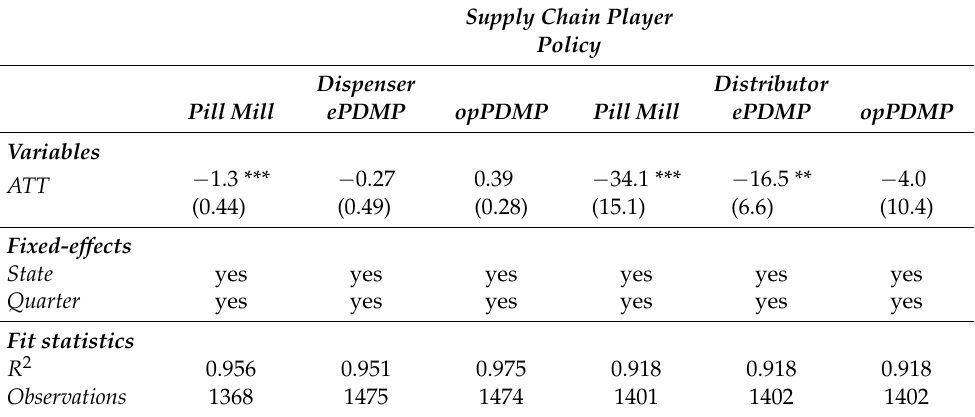
Figure 5. Amount of opioid drugs shipped from distributors in TN to neighbor states per destination capita after OP-PDMP implementation in TN, excluding manufacturing buyers; Signif. Codes: **: 0.05, *: 0.1, P: Positive Correlation, N: Negative Correlation; Source: ARCOS. Table 1. PDMP and Pill Mill policies impact on opioid distributors and dispensers as the main supply chain players. The impact is evaluated through DiD method over PCPV bought (sold) by the dispenser